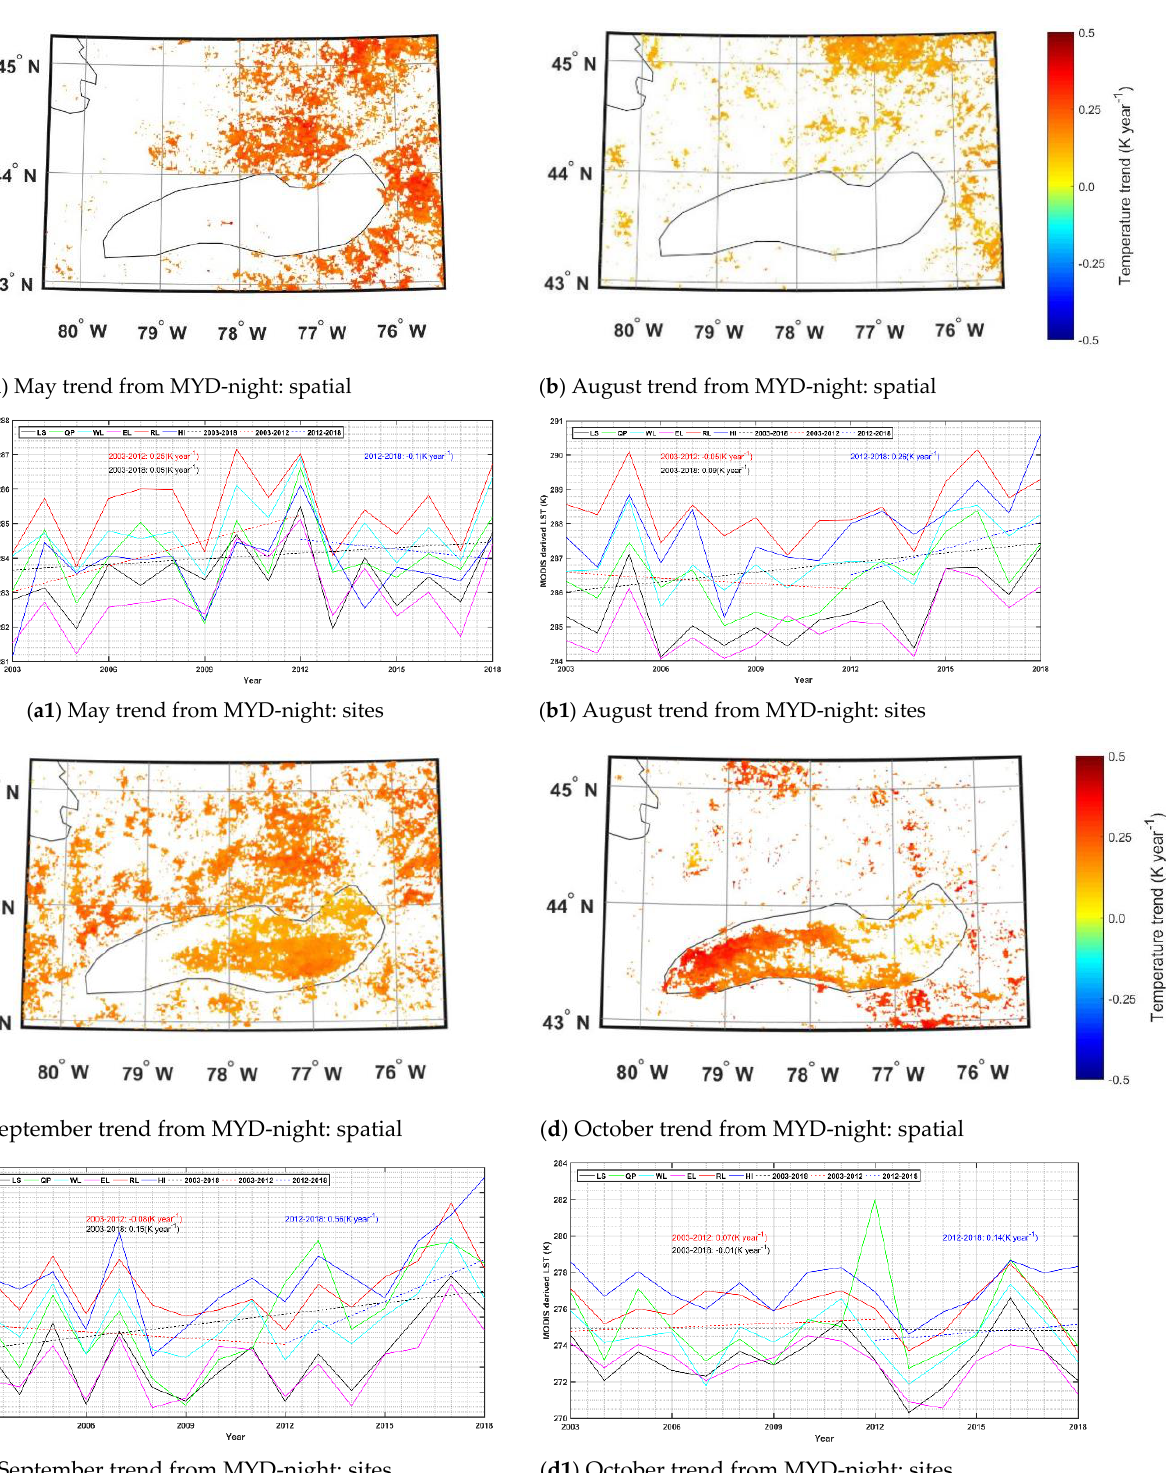
Figure 6. Monthly trend (K year − 1 ) from MYD11A2 nighttime LSWT for the period of 2003 − 2018. May: ( a ) spatial, ( a1 ) site. August: ( b ) spatial, ( b1 ) site. September: ( c ) spatial, ( c1 ) site. October: ( d ) spatial, ( d1 ) site. The dotted lines are the linear regression lines for different time periods, including 2003 − 2018, 2003 − 2012 and 2012 − 2018.